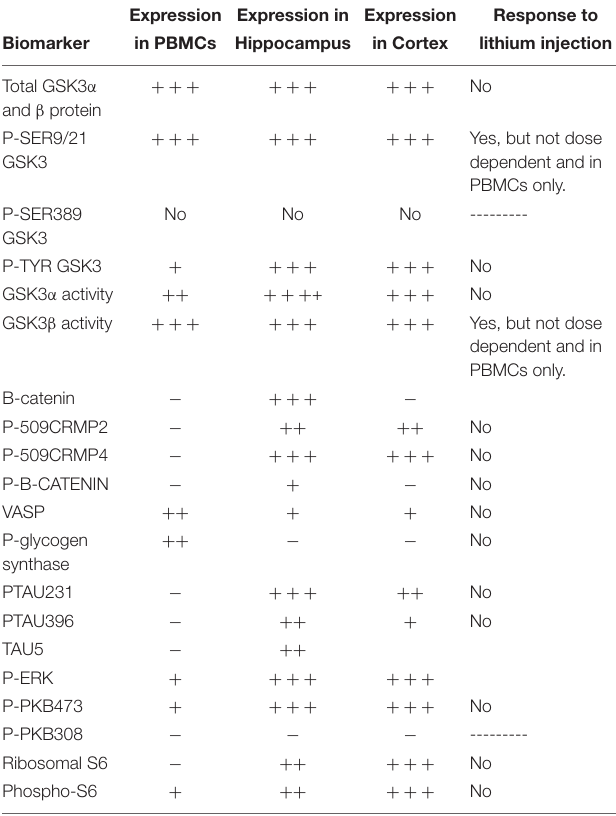
TABLE 5 | Expression of potential biomarkers of GSK3 function in rat tissues. Expression Expression in Expression Response to